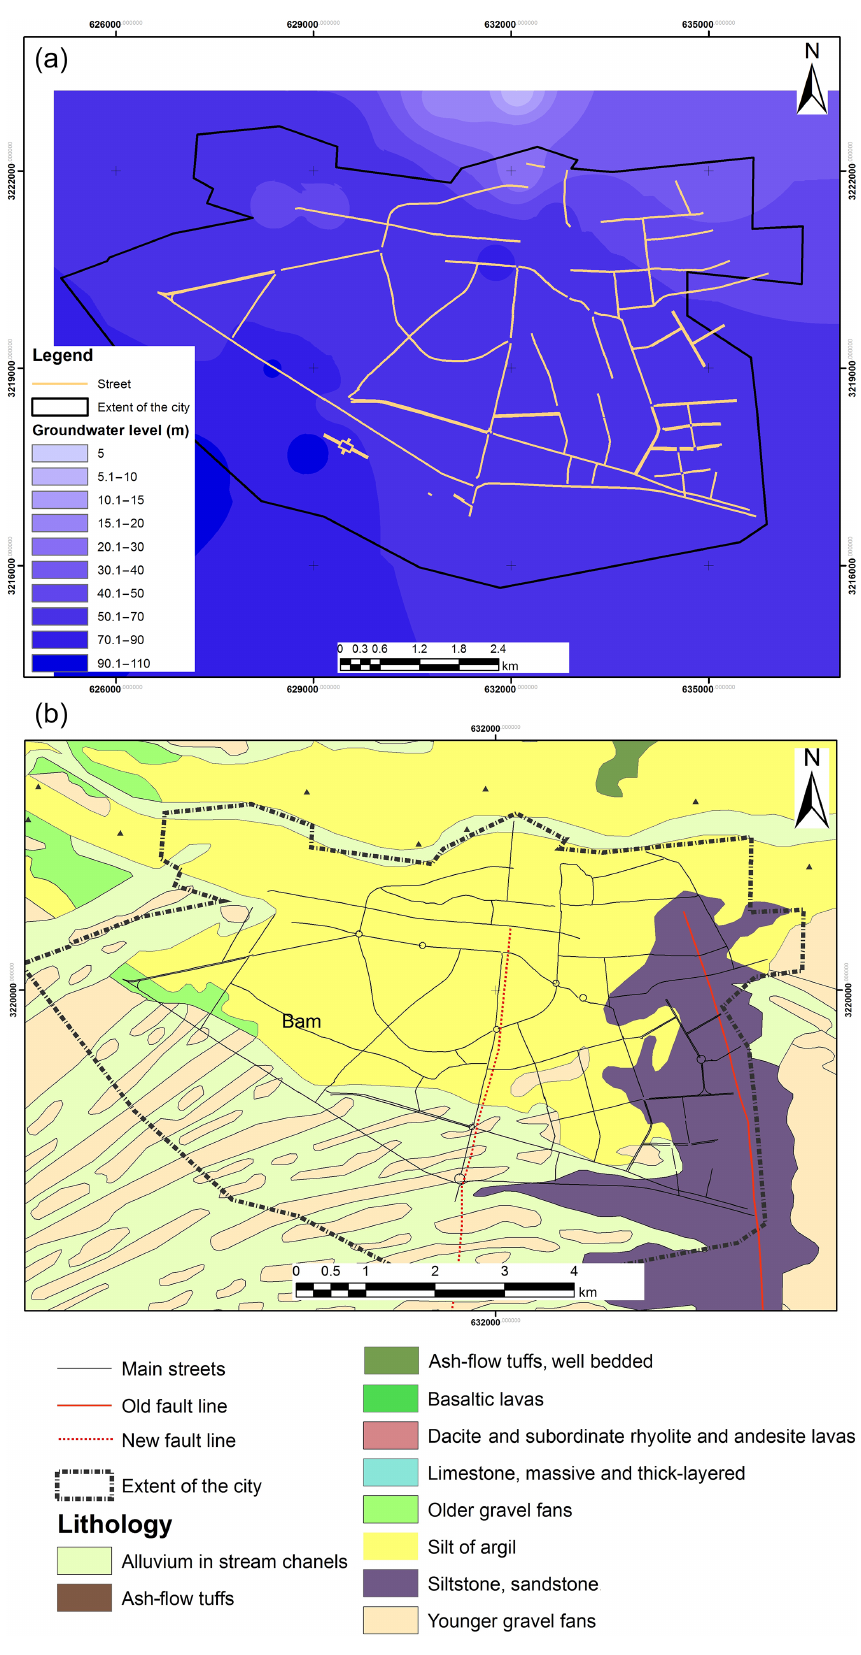
Figure 8. Thematic layers of Bam City: groundwater level (a) and type of rock (Geological Survey of Iran, 1993) (b) . Nat. Hazards Earth Syst. Sci., 19, 1989–2009, 2019